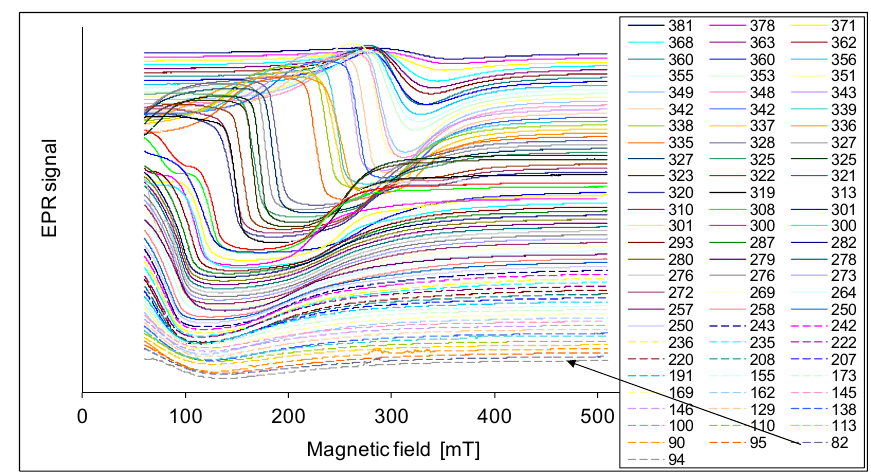
Figure 2. EPR spectra of the sample 2p at various temperatures in K.